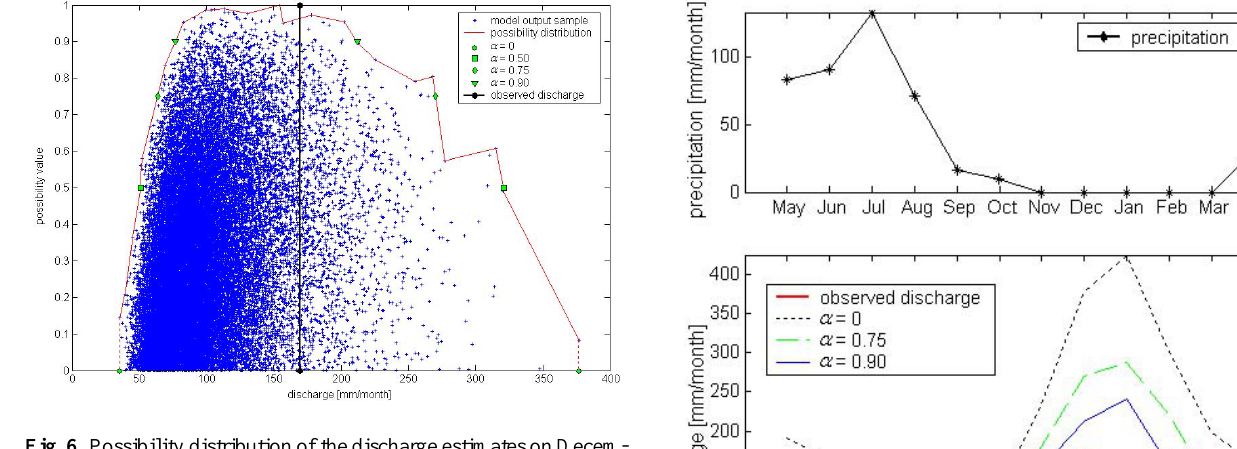
Fig. 6. Possibility distribution of the discharge estimates on Decem- ber 1983 empirically derived from the possibility values π agg 1 ( θ ), observed discharge and selected possibility bounds.